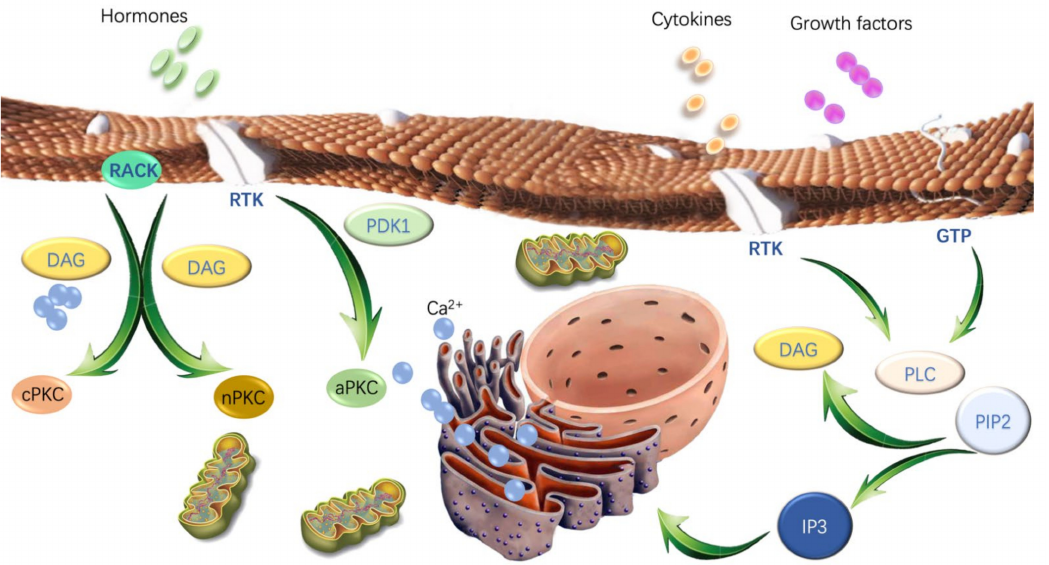
Figure 2. Schematic representation of the activation of protein kinase C (PKC) isoforms. Before activa- tion, PKC isoforms need to be maturated by 3-phosphoinositide-dependent protein kinase-1 (PDK1). Under physiological conditions, PKC can be activated by interacting with extracellular agonists, such as hormones, cytokines and growth factors, which sequentially translocates to different subcellular compartments, thus conferring specific substrate phosphorylation and distinct cellular functions.